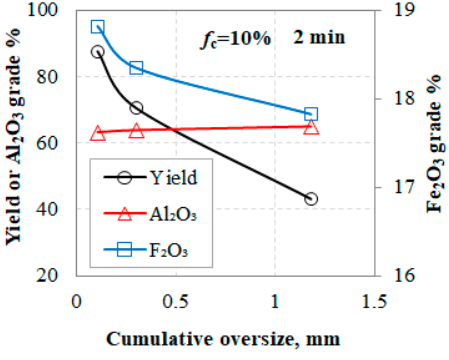
Figure 6. Al 2 O 3 grade, Fe 2 O 3 grade and mass recovery (yield) in the cumulative oversize after 2 min of grinding and when f c = 10%.